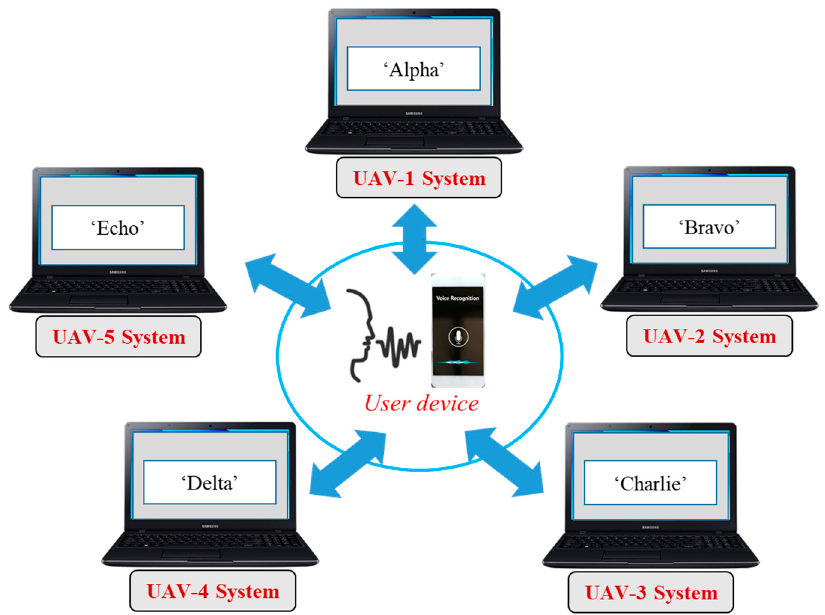
Figure A4. Communication flow of voice trigger-based multi-UAV control. Appl. Sci. 2020 , 10 , 6876